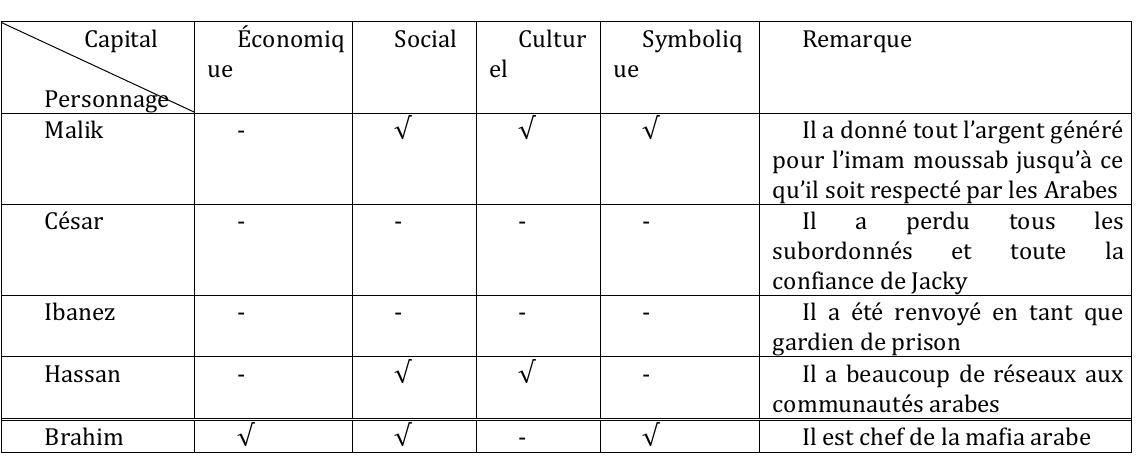
Tableu 3 La propriété finale des capitaux des